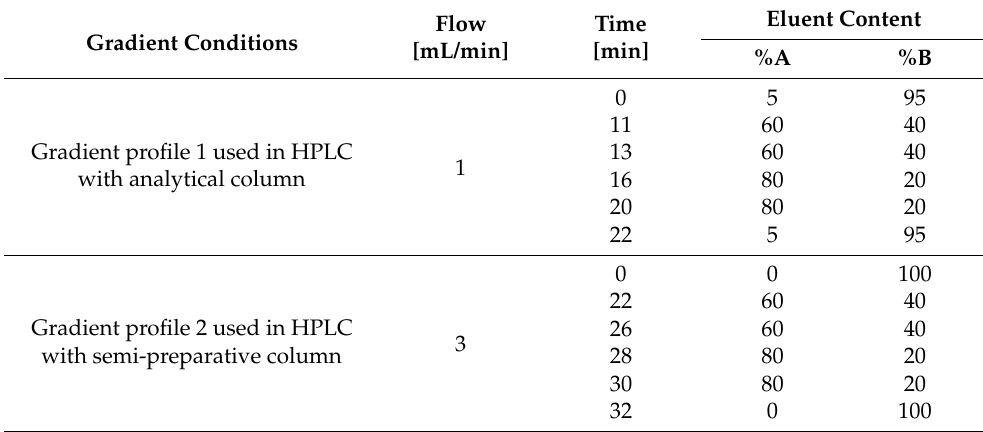
Table 1. Gradient profiles used in HPLC. Gradient